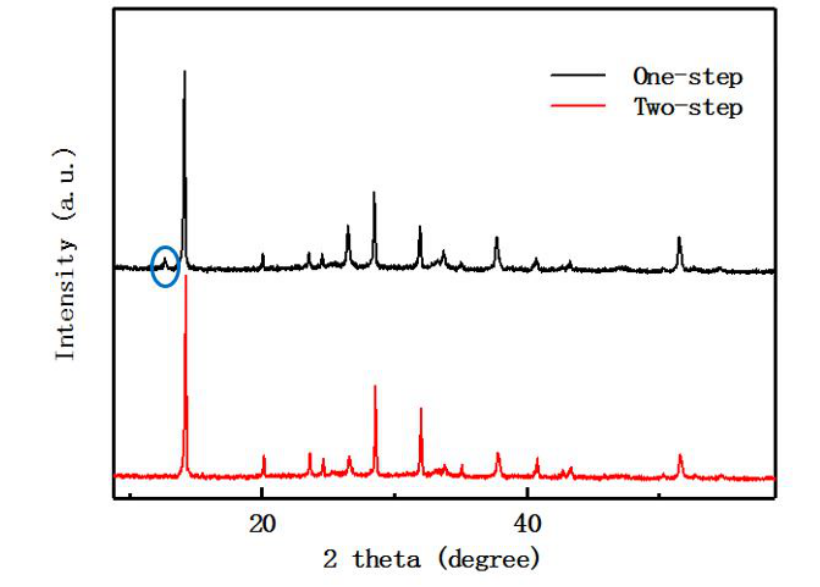
Figure 4. XRD patterns of perovskite films with one-step and two-step. The blue circle is the peak of residual PbI 2